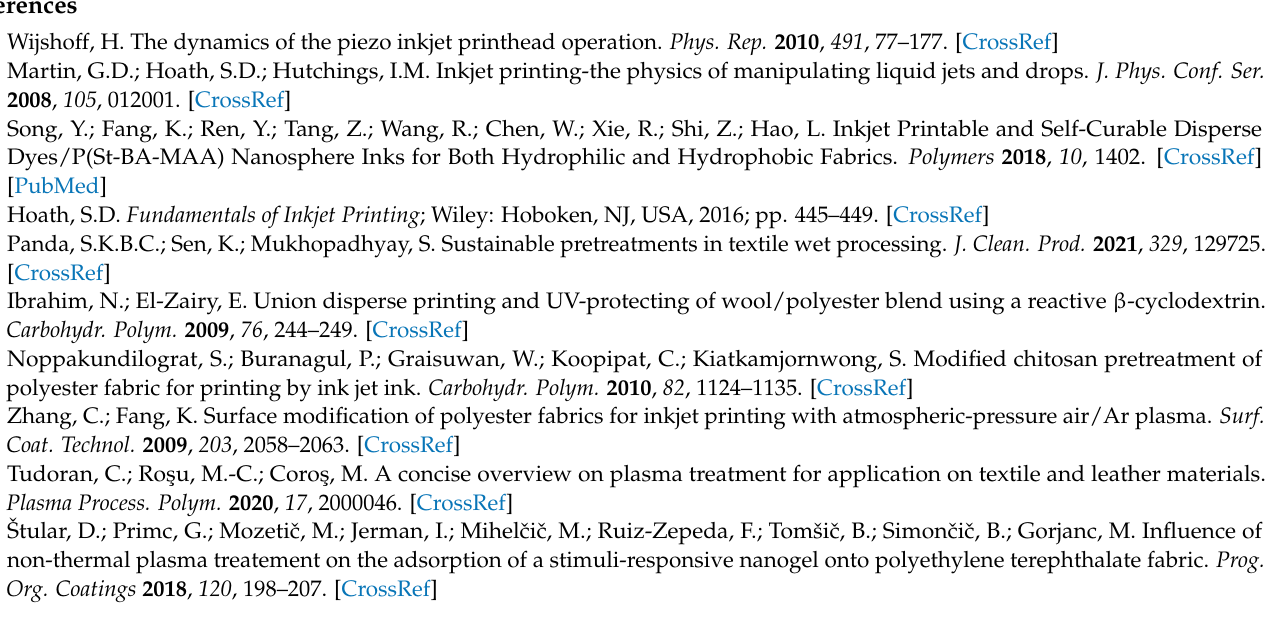
yellow dye inks with different additives and (b) correlation between shear rate and shear stress; Figure S3: Cross-section images of printed PET films: (a) pure PET film; (b) PET film printed with Y-PVP ink; (c) PET film printed with Y-PVA ink; (d) PET film printed with Y-PEG ink; and (e) PET film printed with Y-Control sample; Figure S4: SEM images of fabrics: (a) polyester fabric; (b) polyester fabric printed with Y-Control sample; (c) polyester fabric printed with Y-PVP ink; (d) polyester fabric printed with Y-PVA ink; and (e) polyester fabric printed with Y-PEG ink; Table S1: Physicochemical properties of disperse yellow dye inks; Table S2: The viscosity of the disperse yellow dye inks at different temperatures; Table S3: Color yield and color fastness of the printed polyester fabric using disperse yellow dye inks with different additives and control sample; Table S4: Linewidth and linewidth relative change (W) of printed